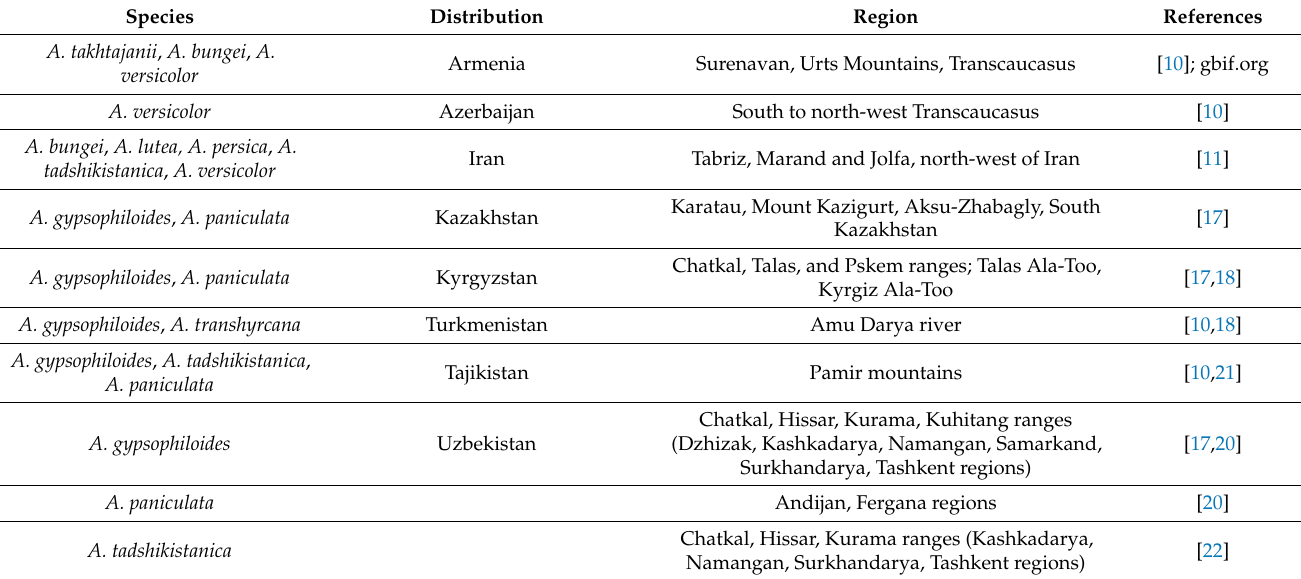
Table 1. Diversity and distribution of different Allochrusa species in